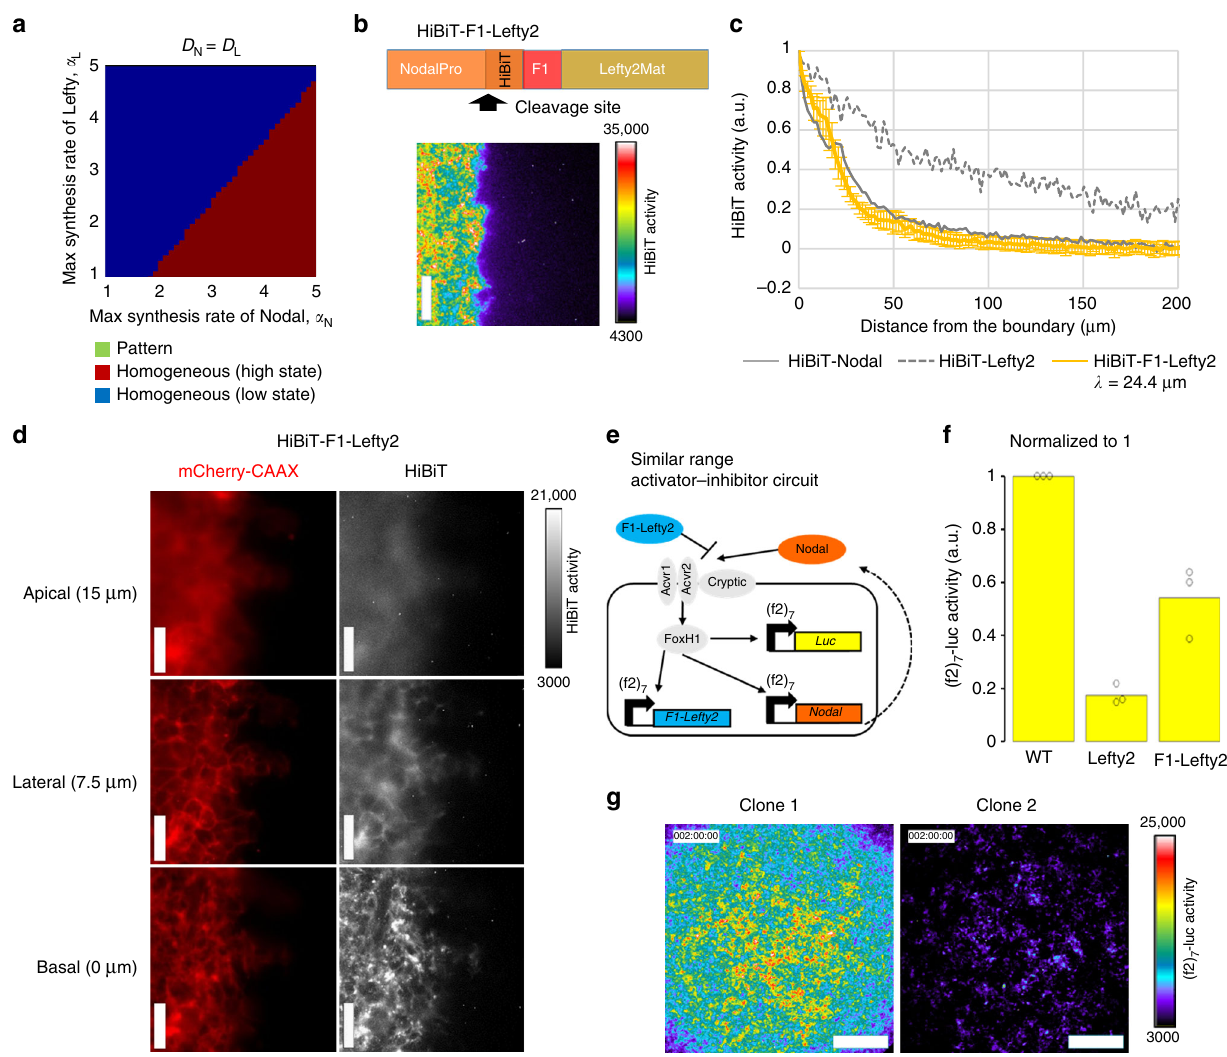
Fig. 4 Different diffusivity of Nodal and Lefty is crucial for the pattern formation. a The parameter region for pattern formation does not exist with the same diffusion coef fi cients for Nodal and Lefty ( D N = D L = 1.96 μ m 2 min − 1 ). The competitive inhibition + direct inhibition model was simulated in one dimension. b Top: the fi nger 1 domain of Nodal was fused to Lefty2. Bottom: the culture insert assay showing the extracellular distribution of HiBiT-F1-Lefty2. c Quanti fi ed distribution pro fi le of HiBiT-F1-Lefty2. The distributions of HiBiT-Nodal and HiBiT-Lefty2 shown in Fig. 2e are displayed as a control. Data are means and s.e.m. ( n = 3). d Higher magni fi cation view of HiBiT-F1-Lefty2. e The similar range activator-inhibitor circuit. F1-Lefty2 was used instead of Lefty2 in the activator-inhibitor circuit to make the diffusion coef fi cients of Nodal and Lefty similar. f Inhibitory activity of F1-Lefty2. Wild-type cells, Lefty2- producing cells or F1-Lefty2-producing cells were co-cultured with the cells engineered with the activator circuit, and the (f2) 7 -luc activities were measured. Data are means and individual points ( n = 3). g The image of two representative clones of the cells engineered with the similar range activator – inhibitor circuit at 48 h. Scale bars: 200 μ m ( b ); 50 μ m ( d ); 400 μ m ( g ). Source data are provided as a Source Data fi le ( c , f